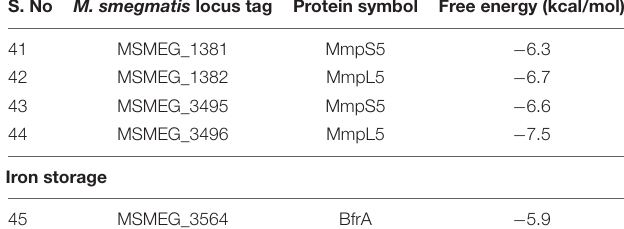
TABLE 1 | List of differential inhibitory efficiency in the form of free energy of binding for against the proteins involved in iron acquisition and transport in M. smegmatis .